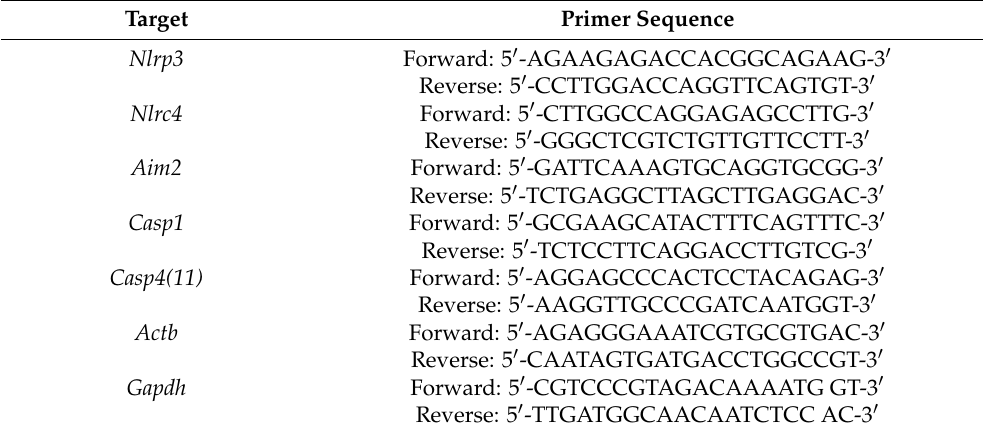
Table 1. Sequences of primers used for qRT-PCR